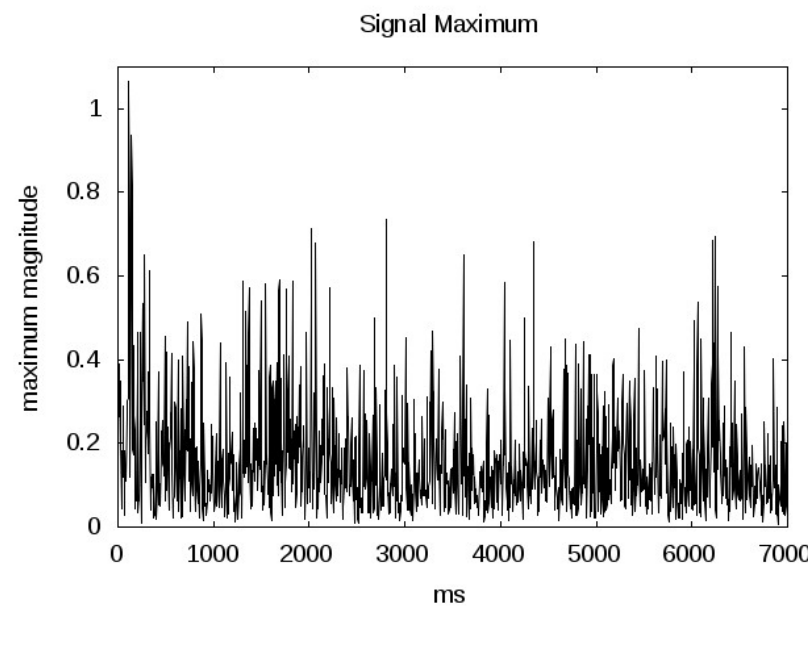
Figure 8. Signal maximums for the June 23 signal. Signal averaged over 5 ms across entire duration of the data collection. The total surface travel distance over this interval is approximately 53 km. Millisecond 0 corresponds to the higher AMSR-E estimated sea ice concentration and millisecond 9000 to the lower sea ice concentration (See Figure